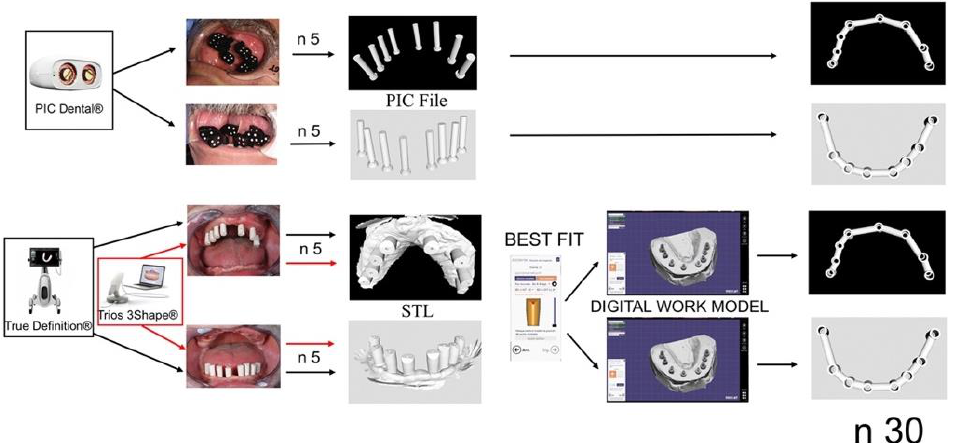
Figure 1. Diagram representing the study design. Three IOSs systems, 5 scans per arch, maxillary mandibular, digital study model, and suprastructure design.